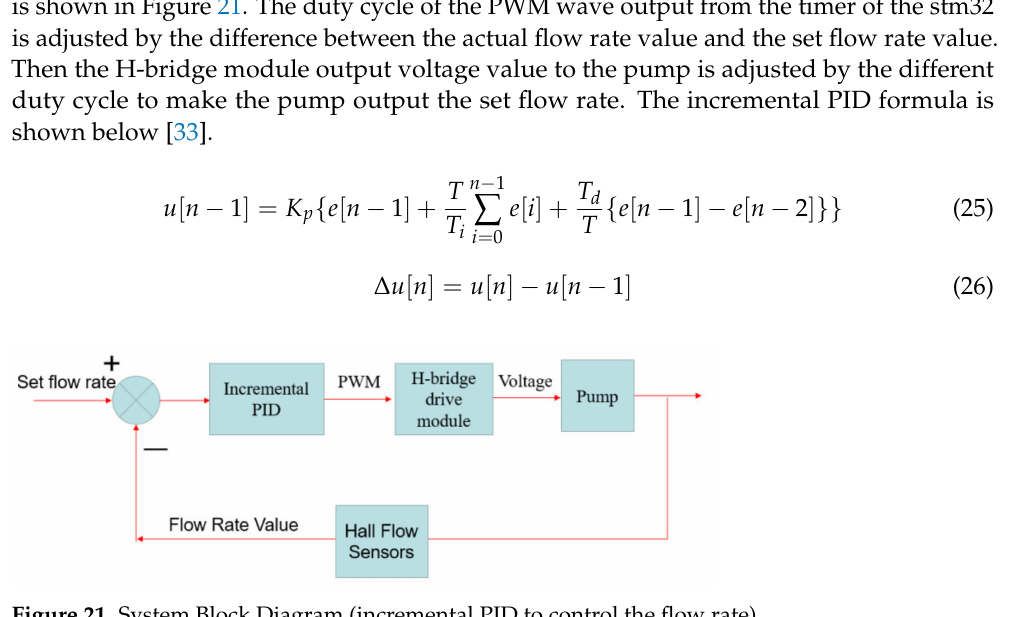
Figure 21. System Block Diagram (incremental PID to control the flow rate). Bring Equation (25) to (26) to get Equation